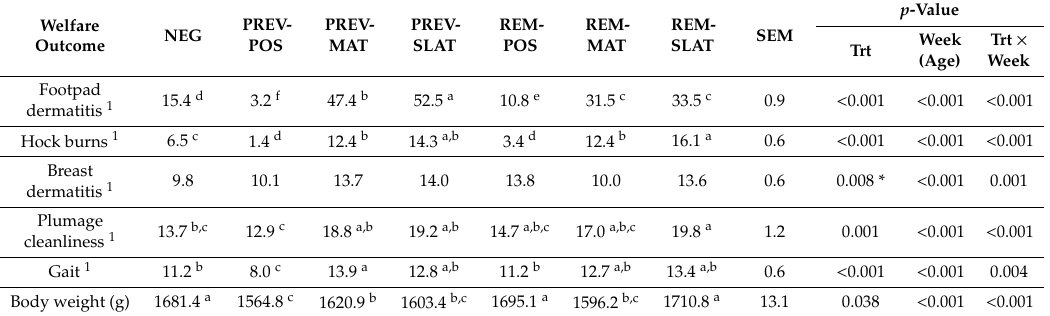
Table 3. LS MEANS (and SEM) of the welfare outcomes for all flooring × timing treatment combinations (trt). p -values of the main and interactive e ff ects are given for all welfare outcomes. Welfare Outcome